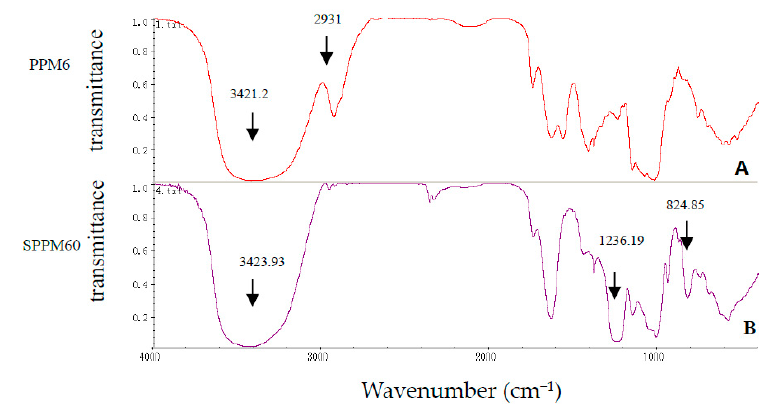
Figure 1. The infrared spectrum of PPM60-D ( A ) and SPPM60-D ( B